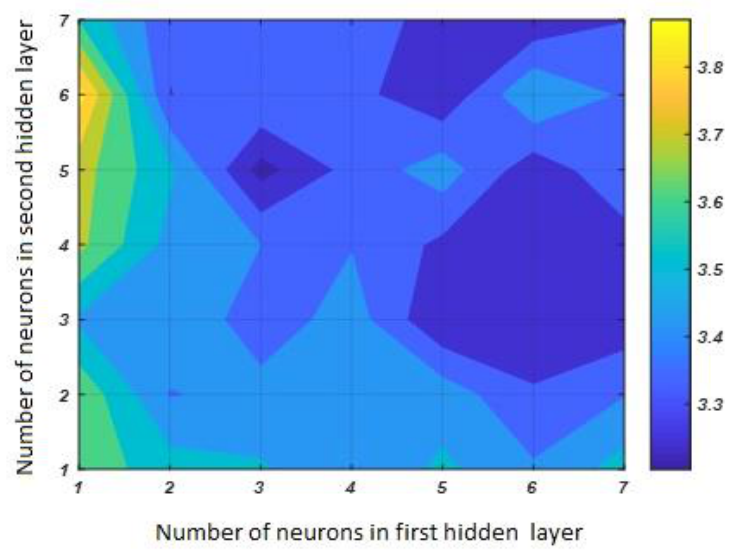
Figure 6. The number of neurons of hidden layers versus MSE of the training data set